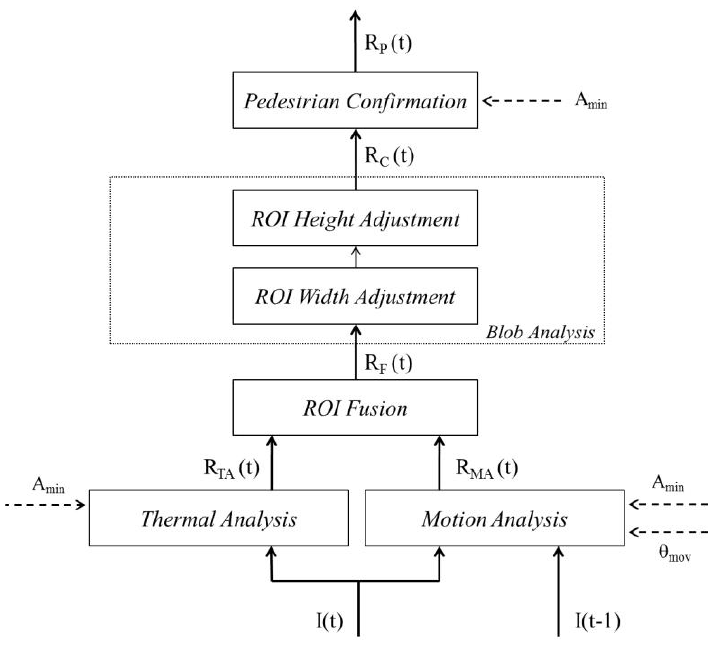
Figure 1. Algorithm for pedestrian ROI extraction in thermal-infrared